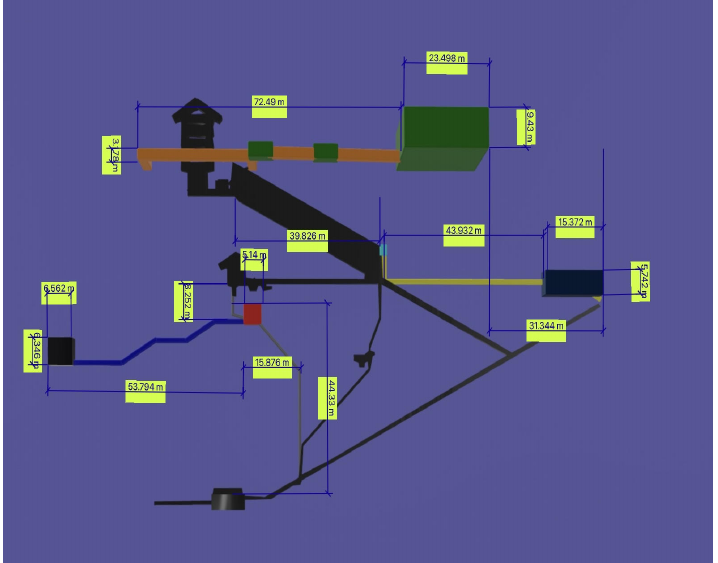
Figure 58. Measurements of the detected facilities of the pyramid. The numbers shown after the comma cannot be significant. (East-side